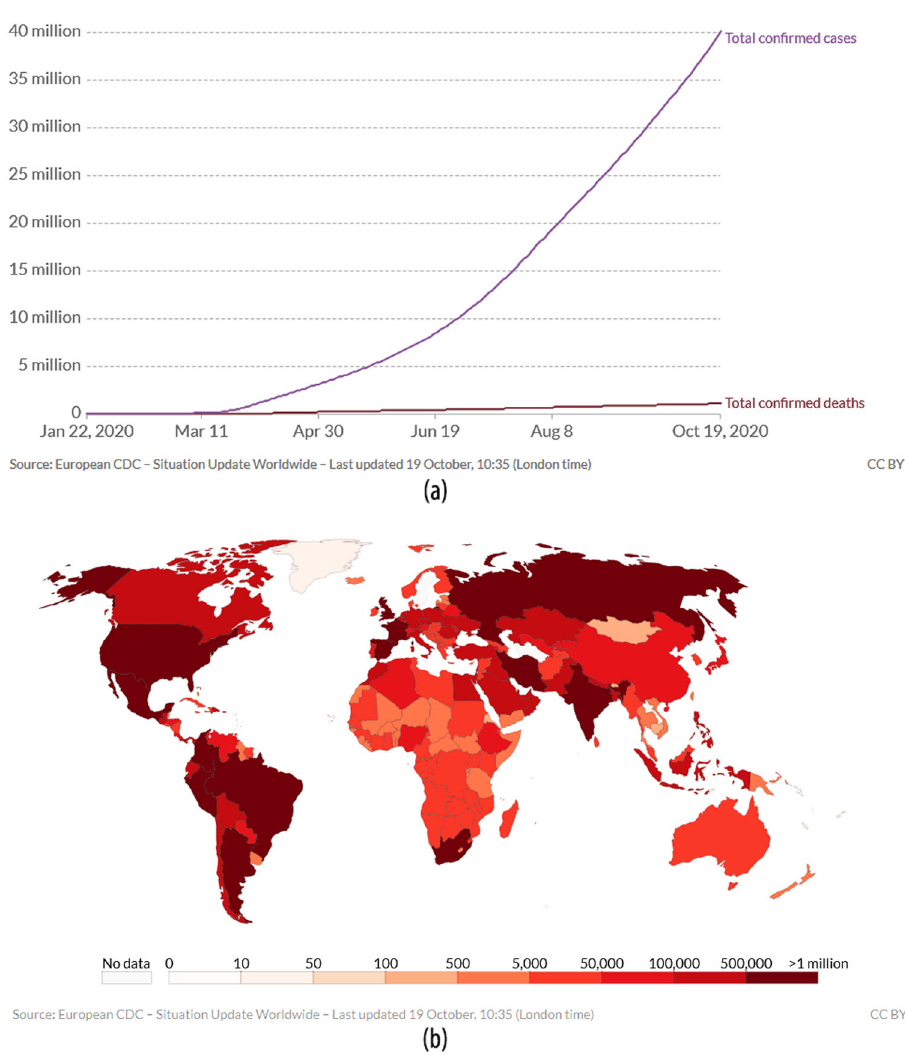
Fig. 2 Graph and Map showing the con fi rmed COVID-19 cases and deaths across the world till 19 October 2020. : This fi gure is covered by the